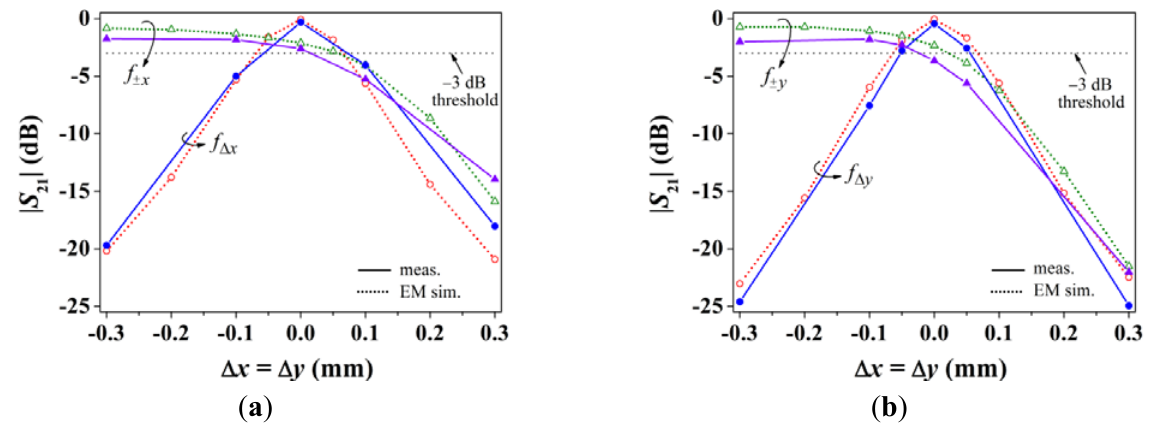
at the indicated 21